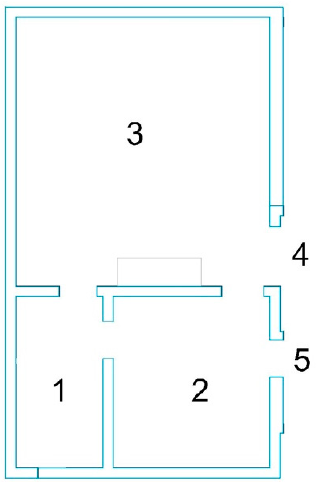
Table 3. Distribution of Escape Demand.